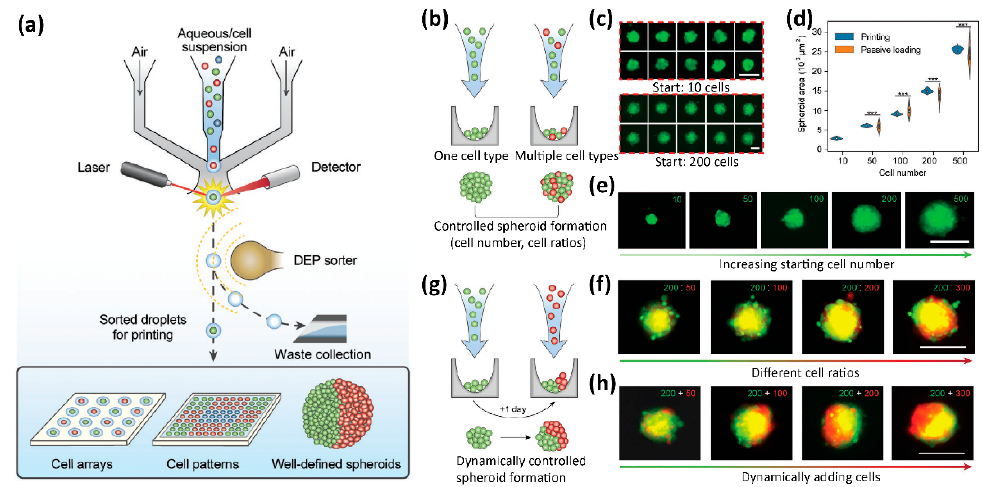
Figure 7. ( a ) Schematic illustration of the high-definition single-cell printing (HD-SCP) system. ( b ) Schematic illustration of controlled spheroid formation with HD-SCP. ( c – e ) The size of the spheroids can be precisely controlled by the initial number of the printed single cells. ( f ) Multicellular spheroids formed by printing multiple cell types with different cell ratios. ( g ) Schematic illustration of dynamically controlled spheroid formation with HS-SCP. ( h ) Bioprinting multicellular Janus spheroids. Scale bars: 100 µm for ( c ) upper, and 200 µm for ( c ) lower, ( e , f , h ). Reproduced with permission from [116].